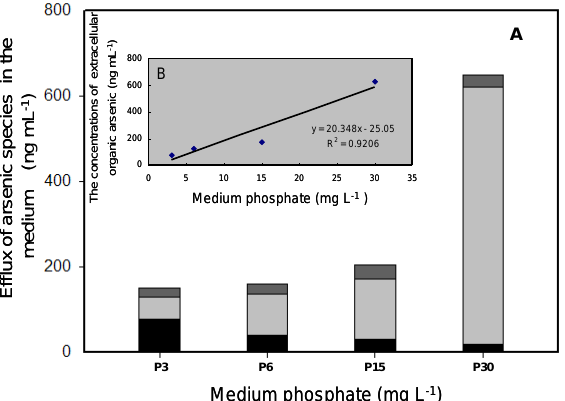
Figure 5. Efflux of As speciation in the medium after cultures were grown for 20 h by T. pyriformis . ( A ) Concentrations of As species. Black: As(III); gray: DMAs(V); dark gray: MMAs(V); ( B ) The relationship between extracellular organic As concentrations and the initial P levels. All data are the means ± SE ( n =